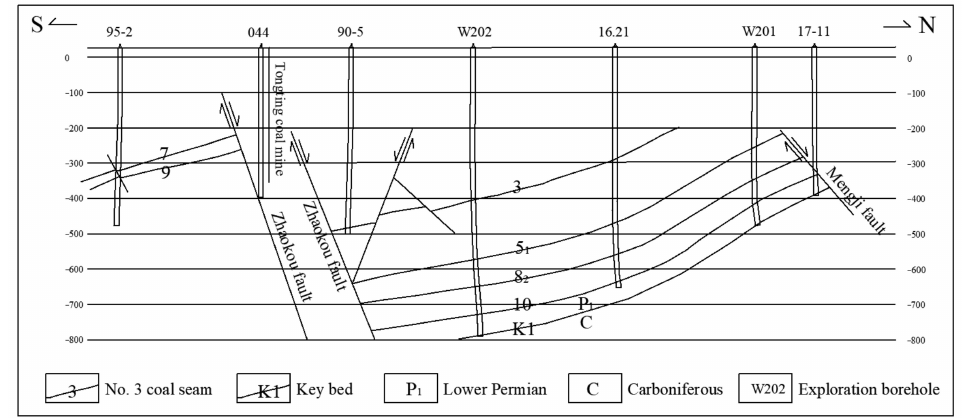
Figure 7. Geological section of no. w20 exploration line at the Tongting coal mine. Simplified from